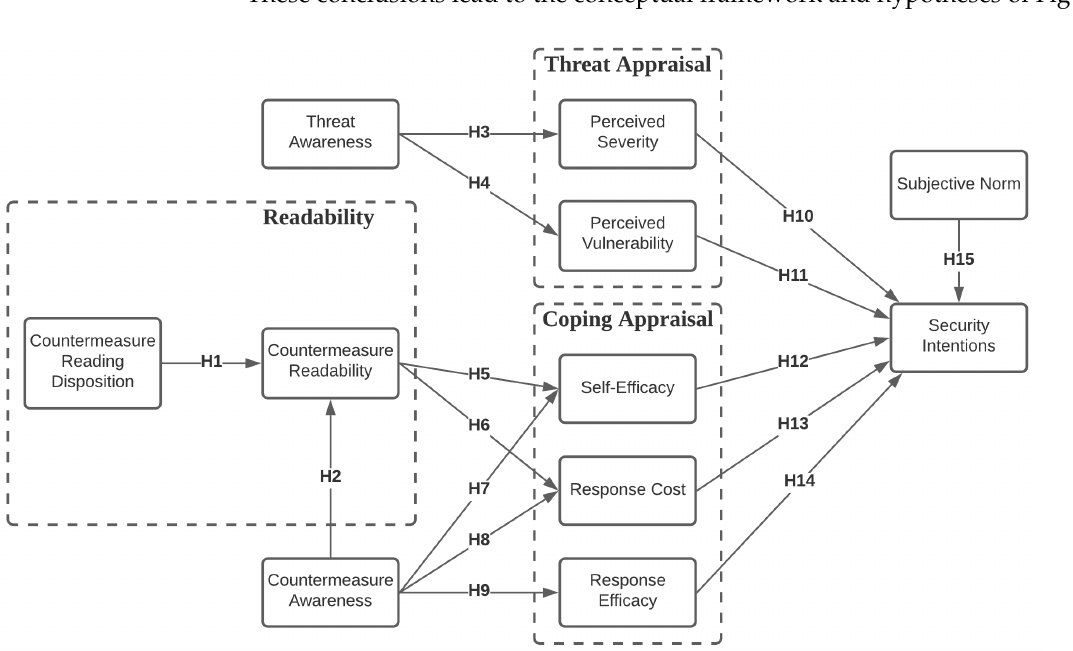
Figure 2. Proposed conceptual framework. An extended PMT model applied to a cybersecurity context based on Hanus and Wu